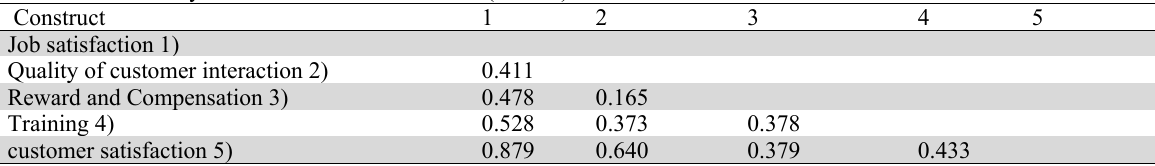
Discriminant Validity: Heterotrait-Monotrait Ratio (HTMT)